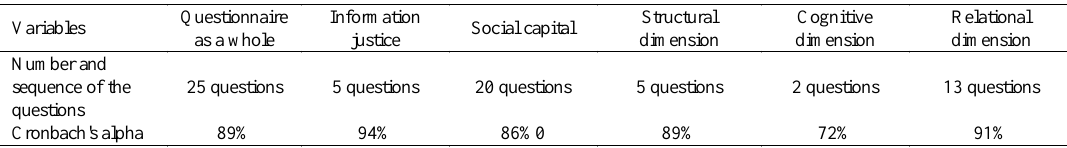
Table 1: Cronbach α calculation